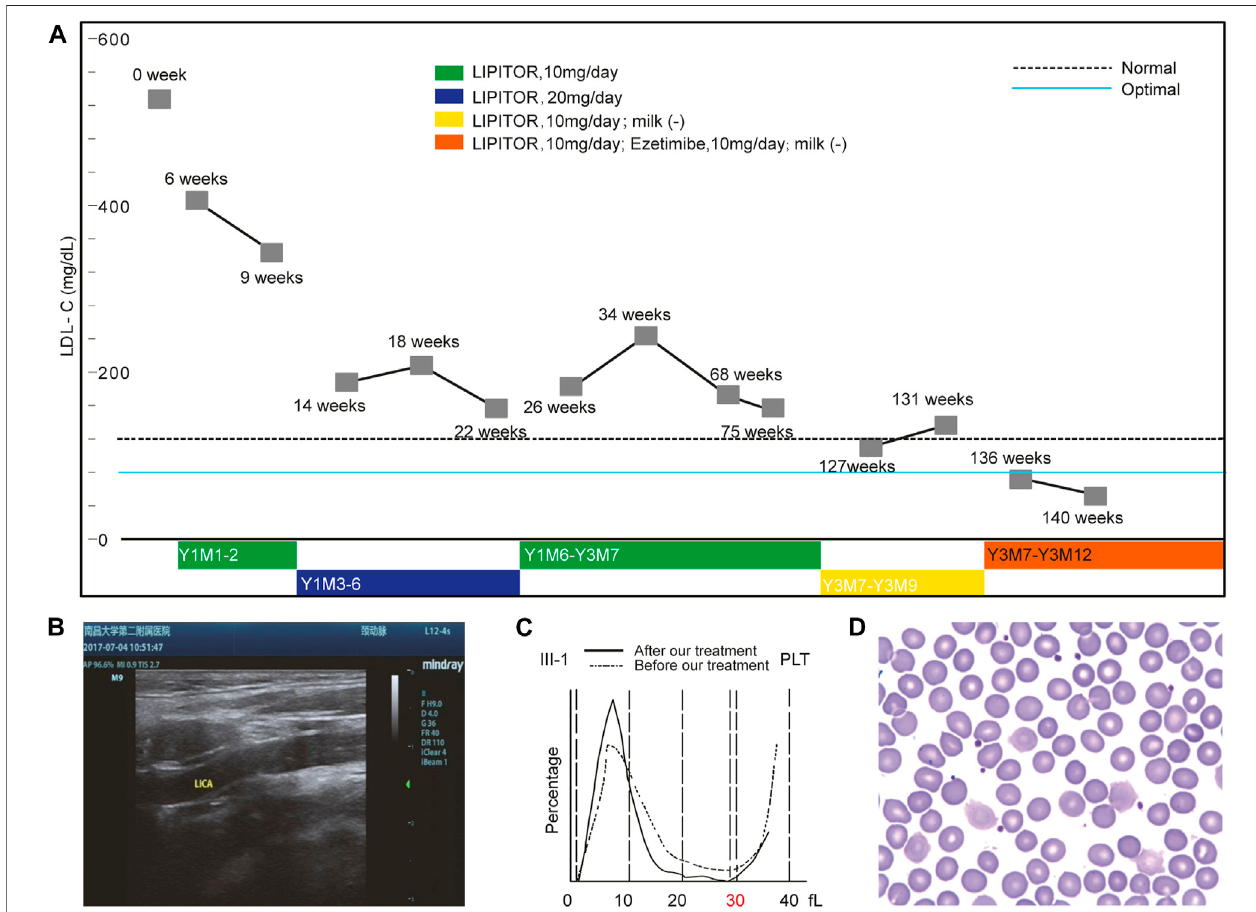
FIGURE 2 | Ezetimibe Corrected the Phenotypes of the Proband. Panel (A) shows the changes in the LDL-C levels under an optimized treatment regimen. Panel (B) shows the disappearance ofthe aforementioned atherosclerotic plaque revealed by the ultrasound scan after Ezetimibe treatment. Panel (C) shows the comparison of platelet size distributions before and after Ezetimibe treatment in the proband. Panel (D) shows the disappearance of the large platelet in the blood smear of the proband after treatment of Ezetimibe.